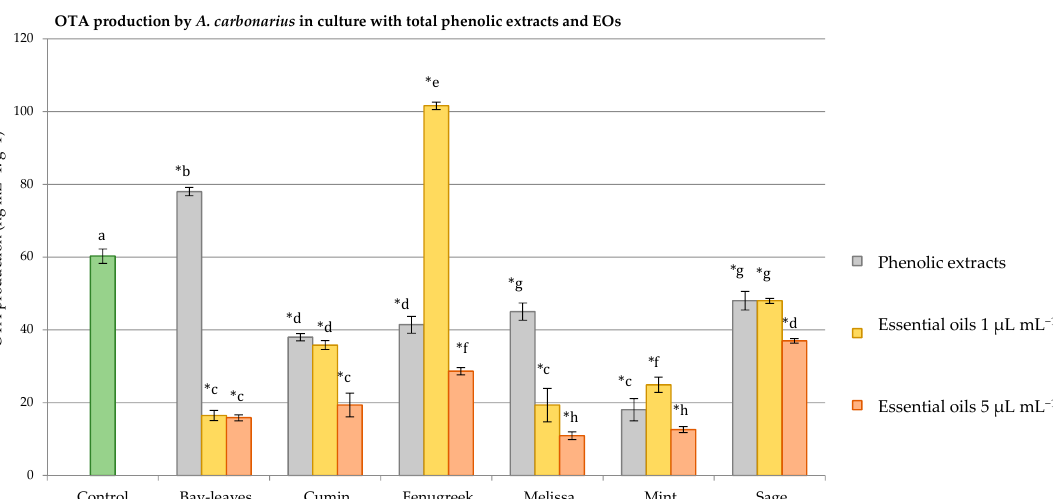
Figure 3. Graphical comparison between phenolic extracts and essential oils at 1 and 5 µL mL − 1 on the dry weight of Aspergilluscarbonarius S402 cultured in a synthetic grape medium at 28 °C for 4 days. Statistical differences are indicated as: * = significant difference ( p < 0.05). Data with the same letters are not significantly different ( p < 0.05).